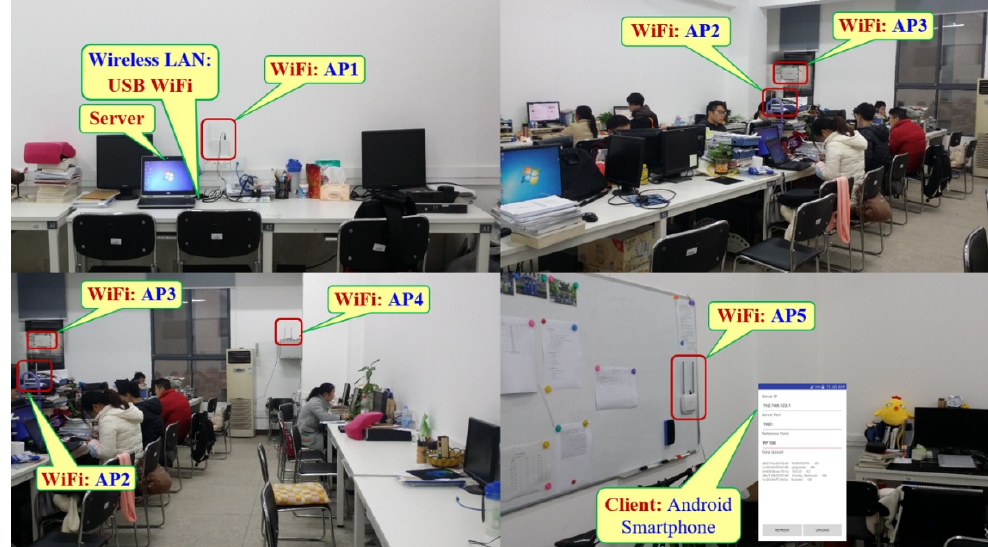
Figure 2. The office room for data collection.